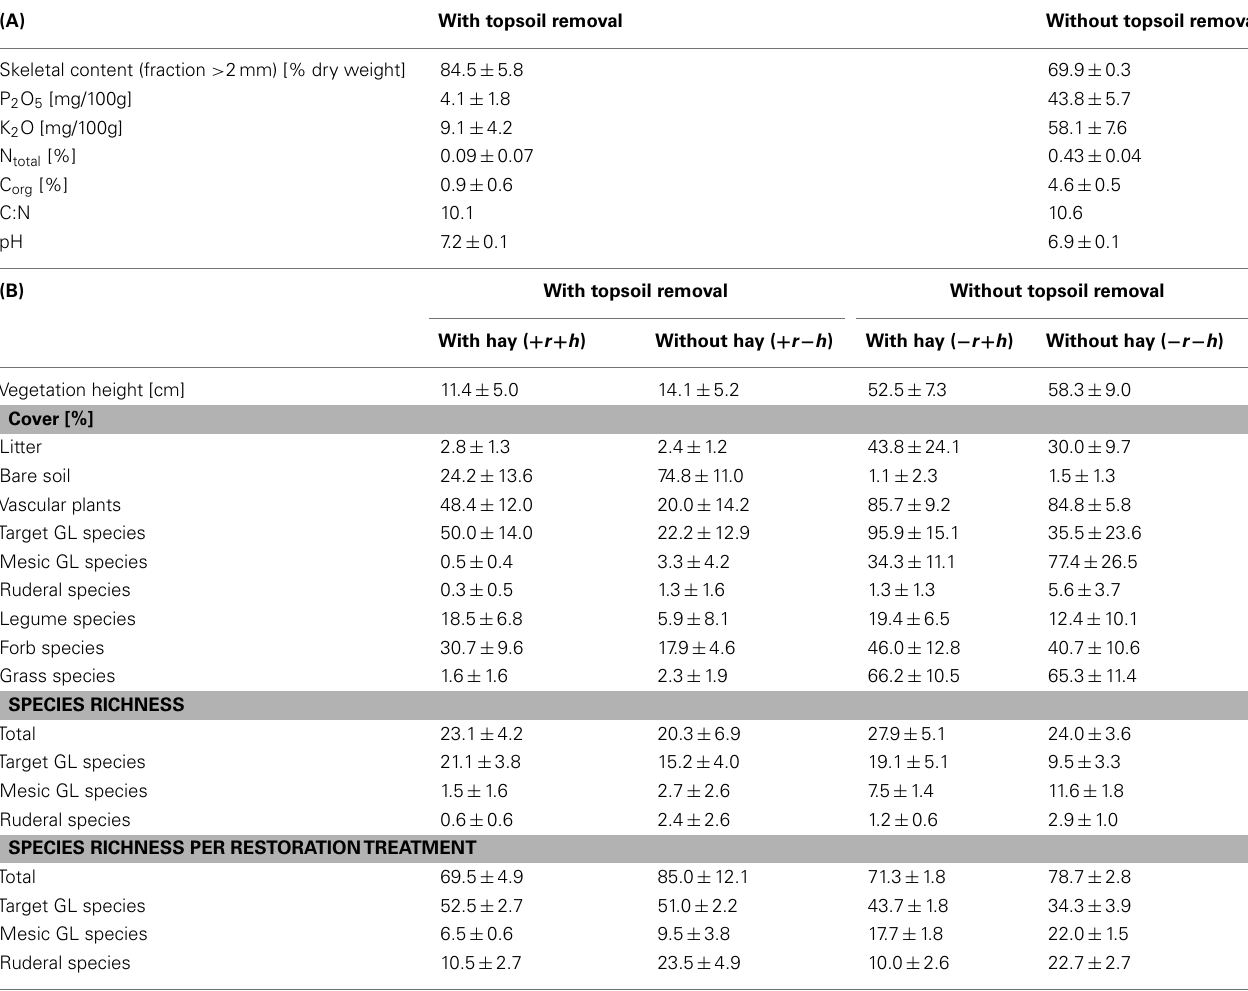
Table 1 | Compilation of abiotic and biotic characteristics in different restoration treatments from previous evaluations at the field site: (A) abiotic soil properties in 2000 (0–10cm, summarized from Pfadenhauer and Kiehl, 2003; Kiehl, 2005), note that nutrient contents and ratios relate to the weight of the fine soil fraction only not the total soil volume, and (B) species cover and species richness in 2006 (summarized from Hummitzsch,